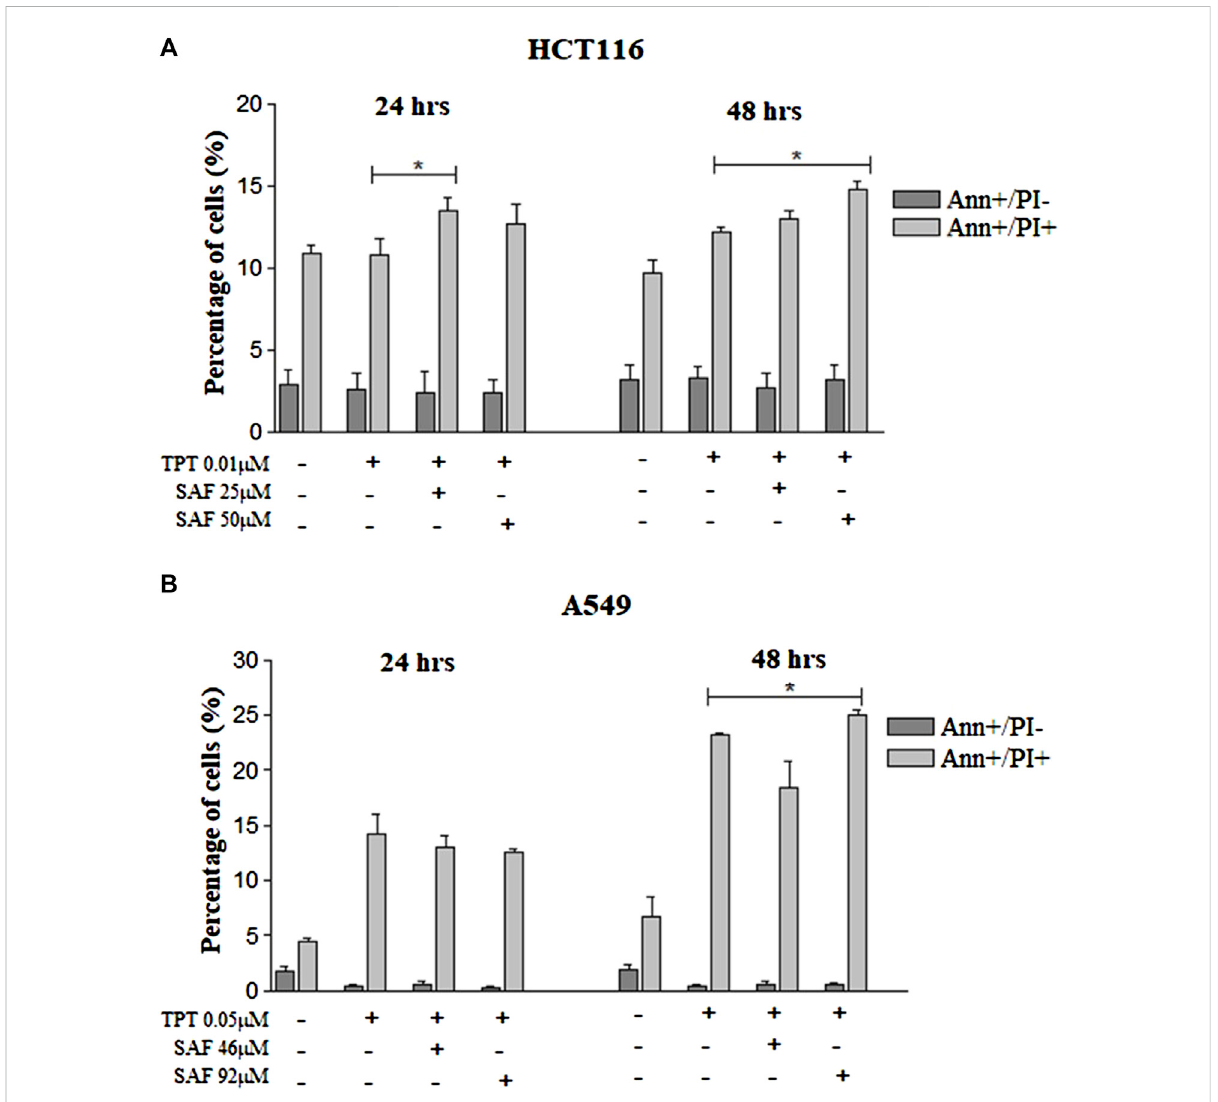
FIGURE 5 Annexin-V/PI fl ow cytometry of HCT116 and A549 cells treated with SAF IC25/IC50 before TPT IC50 treatment. Annexin-V/PI analysis of apoptosis in HCT116 cells (A) treated with SAF IC25/IC50 24 h before TPT 0.01 µM treatment. The combined treatment was incubated for 24 and 48 h. The cells were stained with fl uorescein-conjugated Annexin-V and propidium iodide (PI) and analyzed by fl ow cytometry. The same analysis was performed for A549 cells (B) treated with SAF IC25/IC50 24 h before TPT 0.05 µM treatment. The means ± SEM of at least three independent experiments are shown. * p < 0.05 vs. TPT